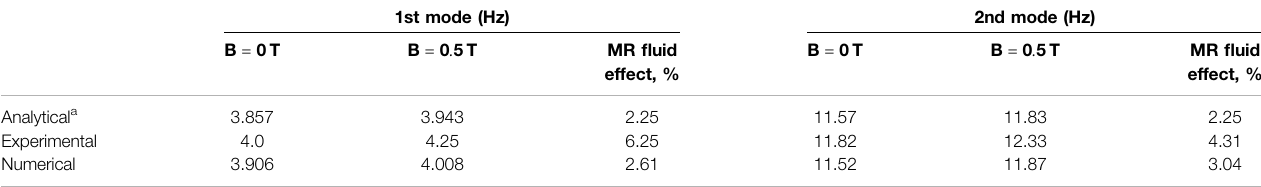
TABLE 3 | Natural frequency shift due to MR fl uid